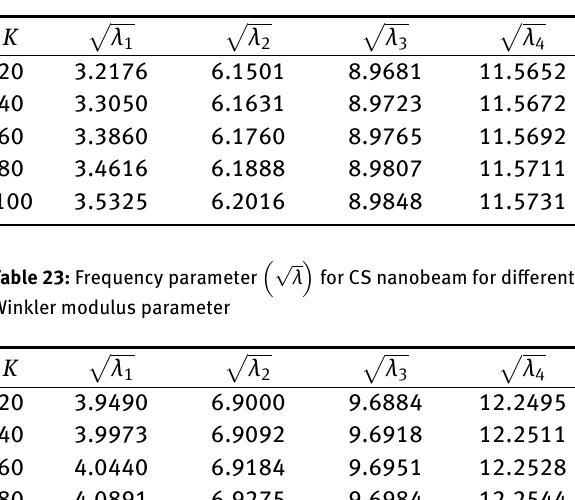
(︁ √ )︁ for CC nanobeam for different λ